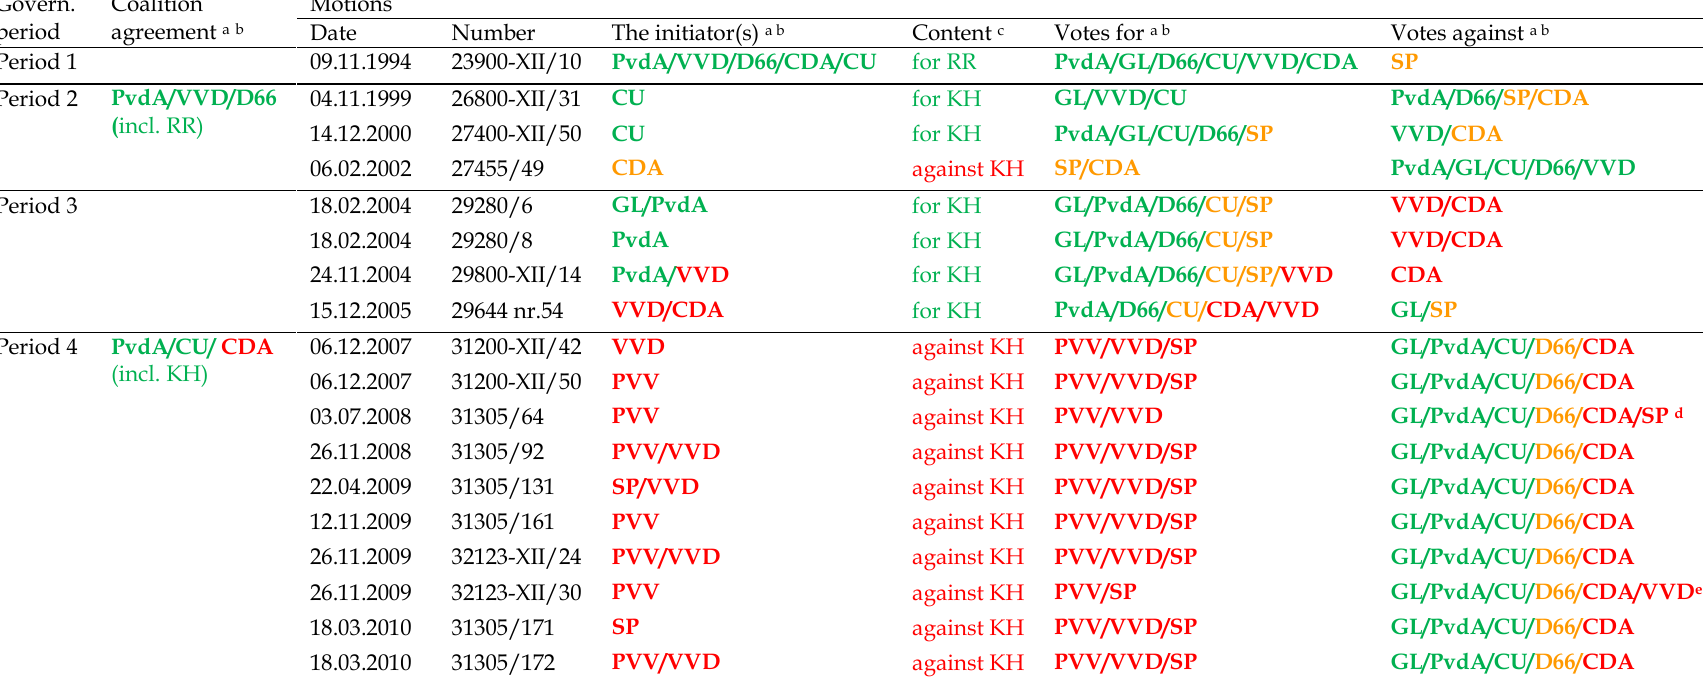
Table 3. Coalition agreements including Rekeningrijden (RR) / Kilometerheffing (KH) and motions for or against RR / KH Govern.